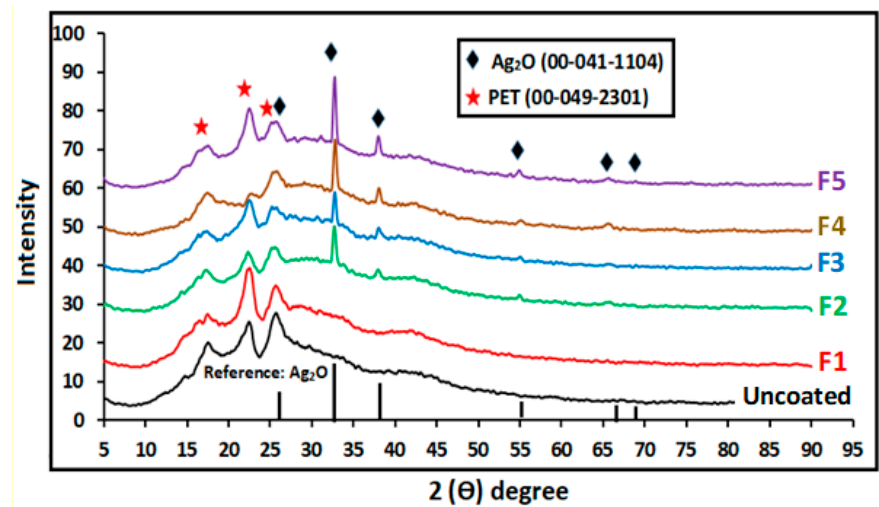
Figure 1. X-ray diffraction (XRD) patterns of synthesized Ag 2 O with different pH.